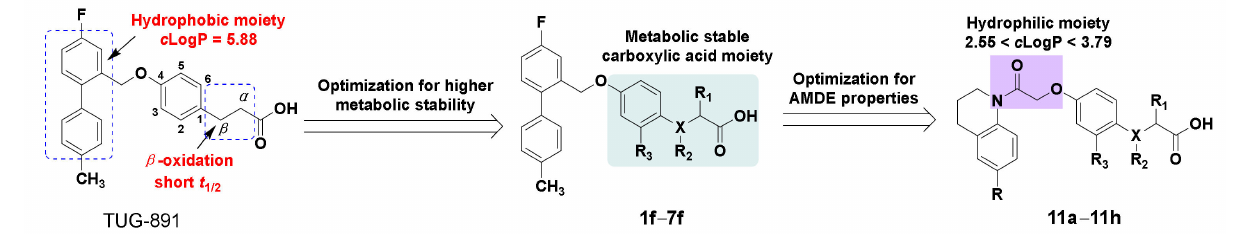
Figure 2. Strategies to improve metabolic stability and hydrophilicity in this